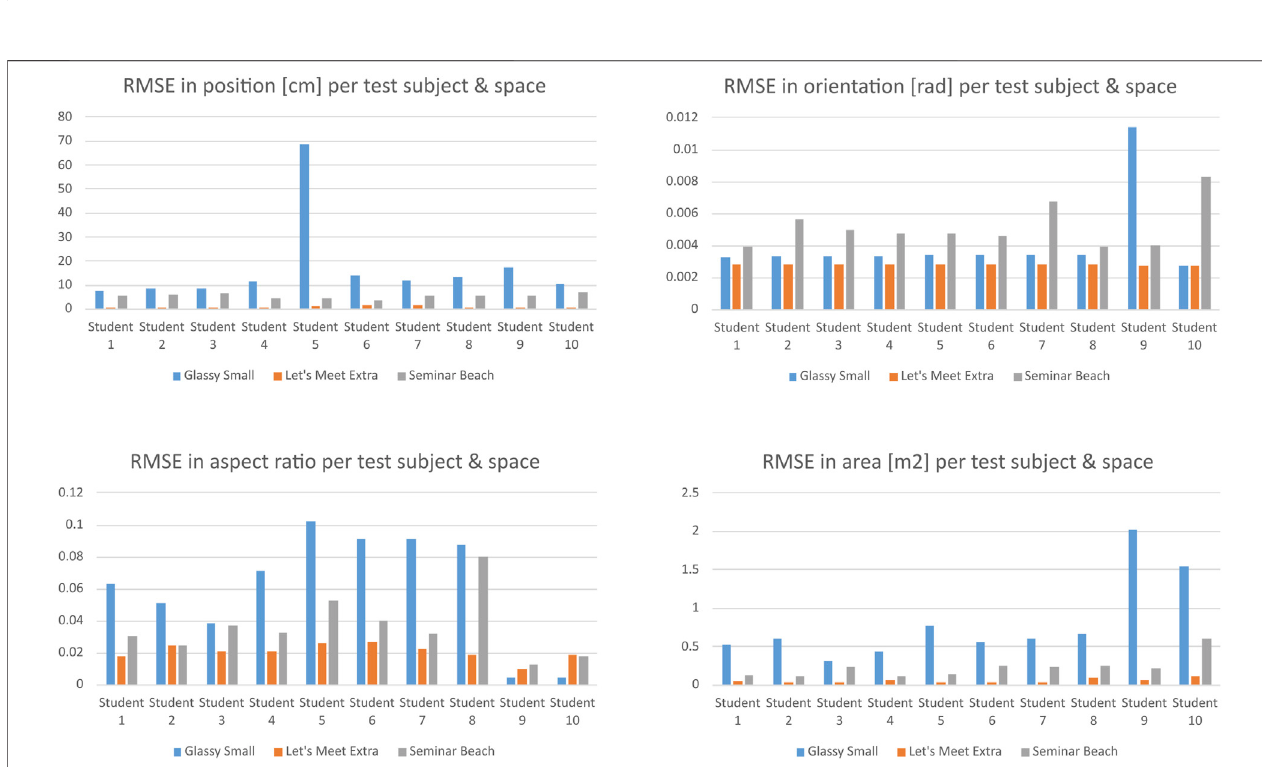
FIGURE 9 | Precision of the manipulation operations, measured as root mean squared error in centimeters (for position), radians (for orientation), and meters squared (for surface area).